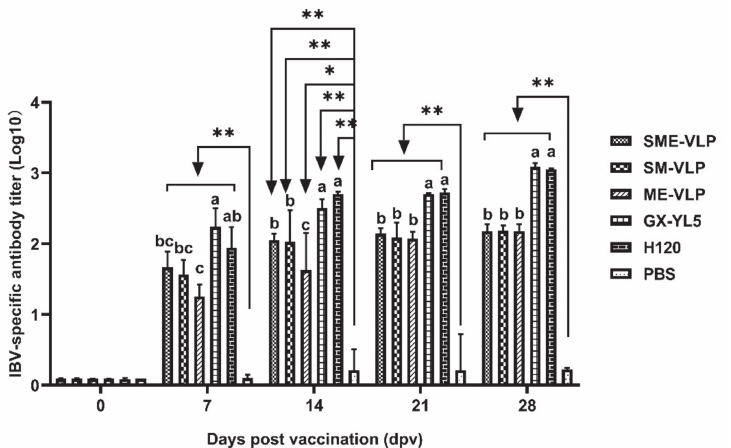
Figure 6. IBV-specific antibody levels in vaccinated chicken sera (0, 7, 14, 21 and 28 days post- vaccination (dpv)) detected by indirect ELISA. Letters (a–c) indicate significant differences among vaccinated groups ( p < 0.05). ** and * indicate p < 0.01 and p < 0.05 between vaccinated and nonvaccinated groups, respectively. ( n = 10